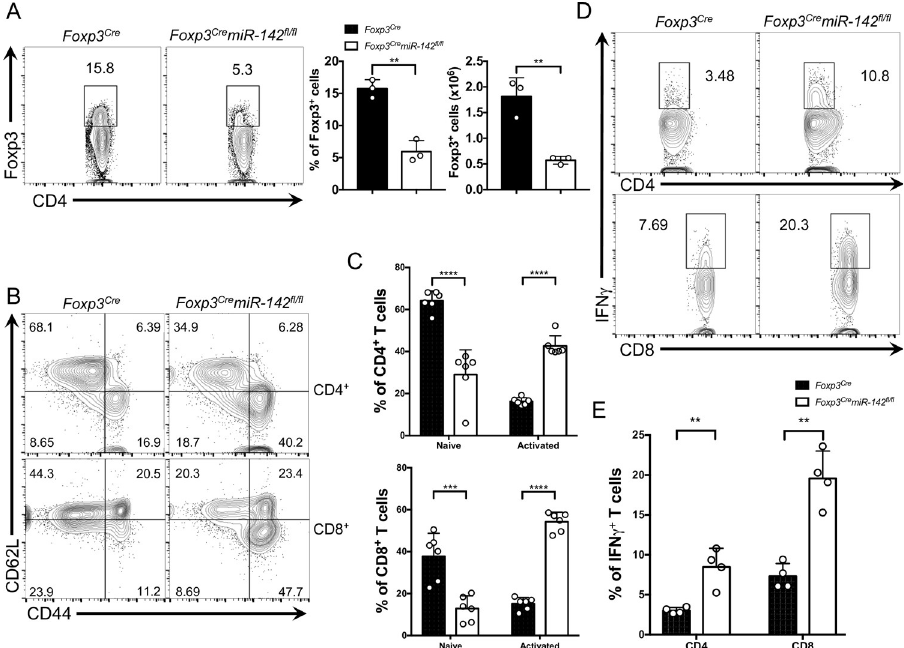
Fig 2. miR-142 is required for maintenance of T reg cell–mediated immune tolerance. ( A ) Left panel, FACS analysis of splenic lymphocytes from 12-week-old Foxp3 Cre and Foxp3 Cre miR-142 fl/fl mice with anti-CD4 and anti-Foxp3 specific antibodies. Numbers indicate percentage of CD4 + Foxp3 + T reg cells in the gate. Right panel, frequency and absolute number of T reg cells in Foxp3 Cre and Foxp3 Cre miR-142 fl/fl spleens ( n = 3 per group). ( B ) FACS analysis of splenic CD4 + and CD8 + T cells from 8- to 10-week-old Foxp3 Cre and Foxp3 Cre miR-142 fl/fl mice with anti-CD44 and anti-CD62L specific antibodies. Numbers indicate percentage of cells in the quadrants. ( C ) Frequency of naive (CD44 − CD62L + ) and activated (CD44 + CD62L − ) splenic CD4 + (top) and CD8 + (bottom) T lymphocytes isolated from 8- to 10-week-old Foxp3 Cre and Foxp3 Cre miR-142 fl/fl mice ( n = 6 per group). ( D ) Intracellular FACS analysis of IFN γ production in splenic CD4 + (top) and CD8 + (bottom) T cells. Numbers indicate percentage of IFN γ + T cells in the gate. ( E) Frequency of IFN γ expressing splenic CD4 + and CD8 + T cells isolated from 8- to 10-week-old Foxp3 Cre and Foxp3 Cre miR-142 fl/fl mice ( n = 4 per group). Results are shown as mean ± SD. P values were calculated using 2-tailed Student t test. �� , P < 0.01; ��� , P < 0.001; ���� , P < 0.0001. The underlying numerical raw data can be found in S1 Data file. The underlying flow cytometry raw data can be found at the Figshare repository. FACS, fluorescence activated cell sorting; IFN γ , interferon gamma; SD, standard deviation; T reg , regulatory